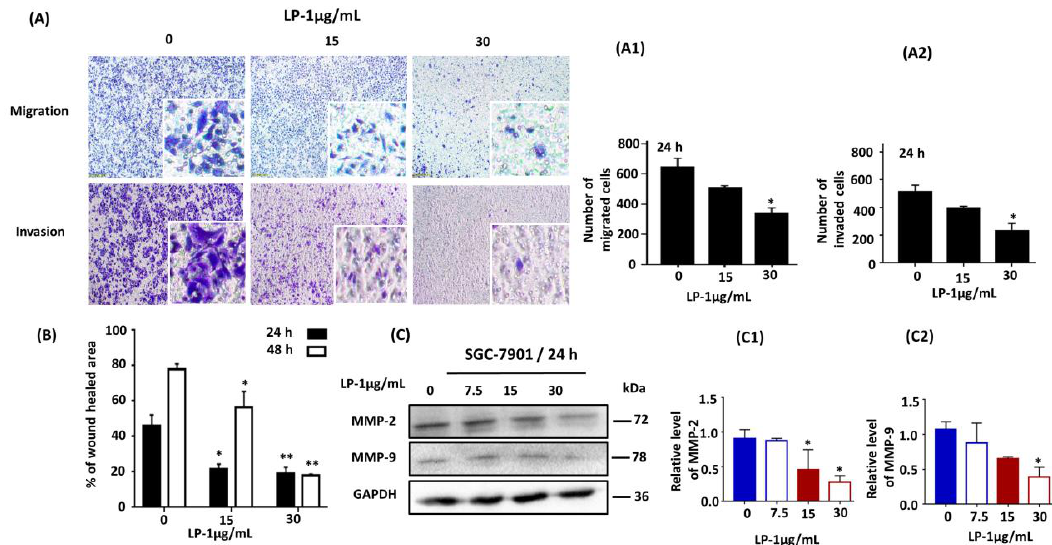
Figure 4. LP1 suppresses migration, invasion and wound healing in SGC-7901 cells. ( A ) Cell migration and invasion assays were performed with (0, 15, 30 µg/mL) of LP1 for 24 h. Images were captured by phase contrast microscope, scale bar 200 µm. ( A1 ) A number of migrated cells quantified by using ImageJ software. ( A2 ) A number of invaded cells quantified by ImageJ software. Cells were counted by three investigators in a double-blind manner. Results are expressed as means ± SD (* p < 0.05) of three independent experiments. ( B ) Wound healing assay was performed with 0, 15 and 30 µg/mL concentrations of LP1 in SGC-7901 cells for 24 and 48 h. Unhealed area was measured by ImageJ software in arbitrary units; results are expressed as means ± SD (* p < 0.05, ** p < 0.01); ( C ) Expression level of MMP-2 and MMP-9 in SGC-7901 cells, treated with various concentrations (0, 7.5, 13, 30 µg/mL) of LP1 for 24 h were analyzed by western blot assay, GAPDH was used as an internal control ( C1 , C2 ). Western blots were quantified by densitometry and results are expressed as mean ± SD (* p < 0.05) of three independent experiments.